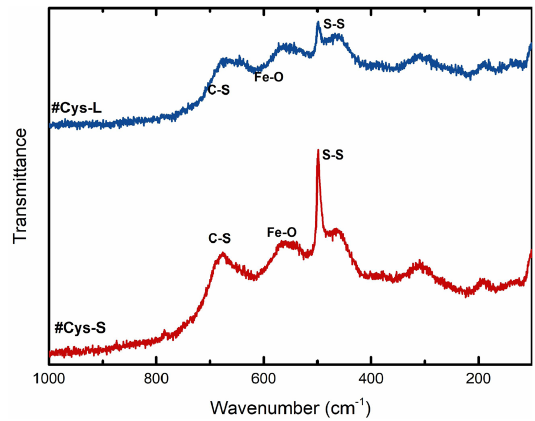
Figure 4. SER spectra of the nanopowder samples. The strong characteristic S–S vibration at 500 cm −1 confirms the formation of cystine in the coating process.